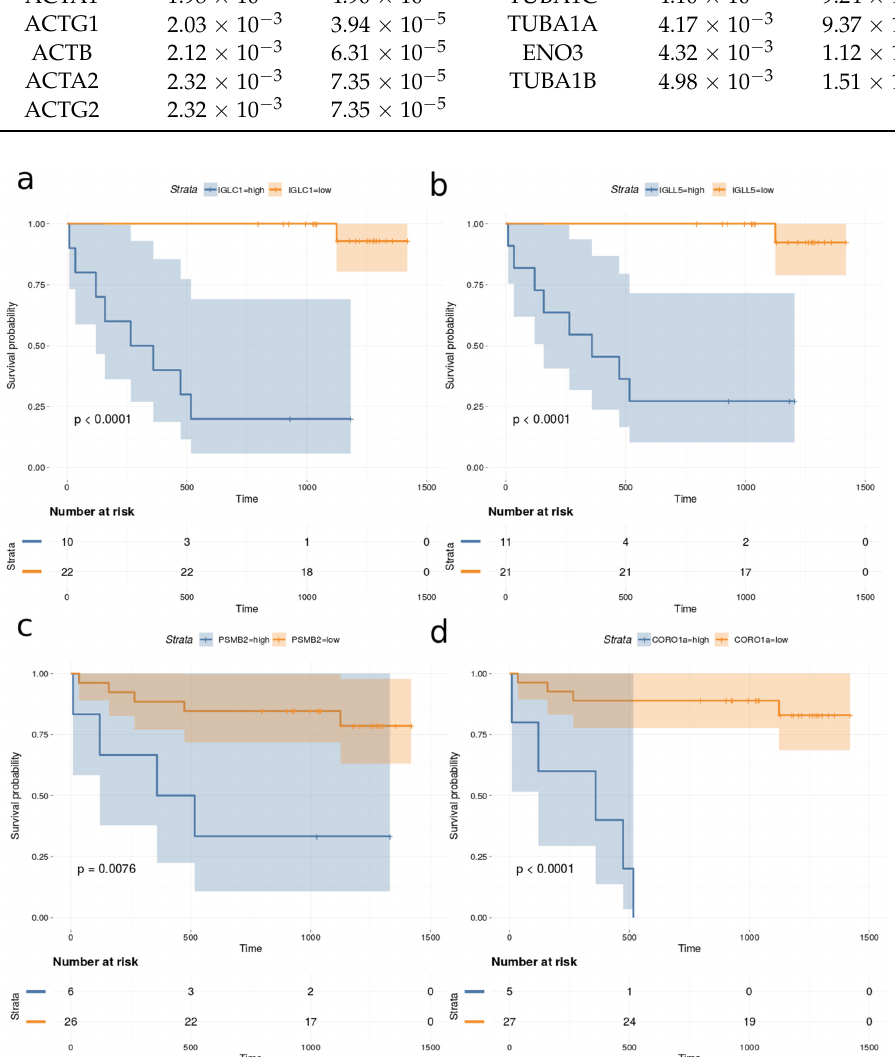
Figure 8. Kaplan–Meier plots based on dividing high and low expression of ( a ) IGLC1, ( b ) IGLL5, ( c ) PSMB2 and ( d ) CORO1a.